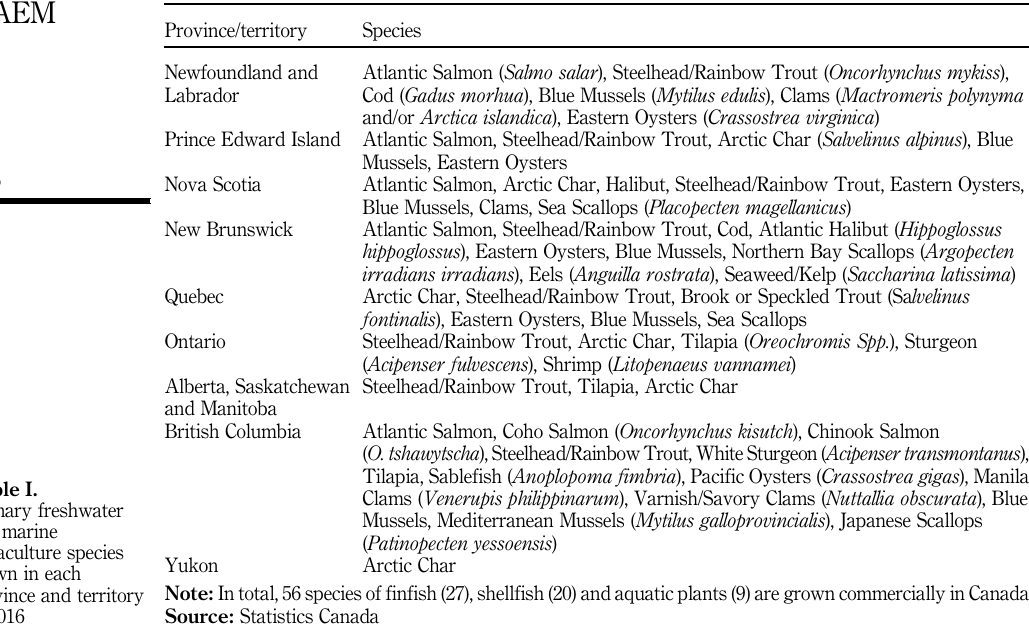
Table I. Primary freshwater and marine aquaculture species grown in each province and